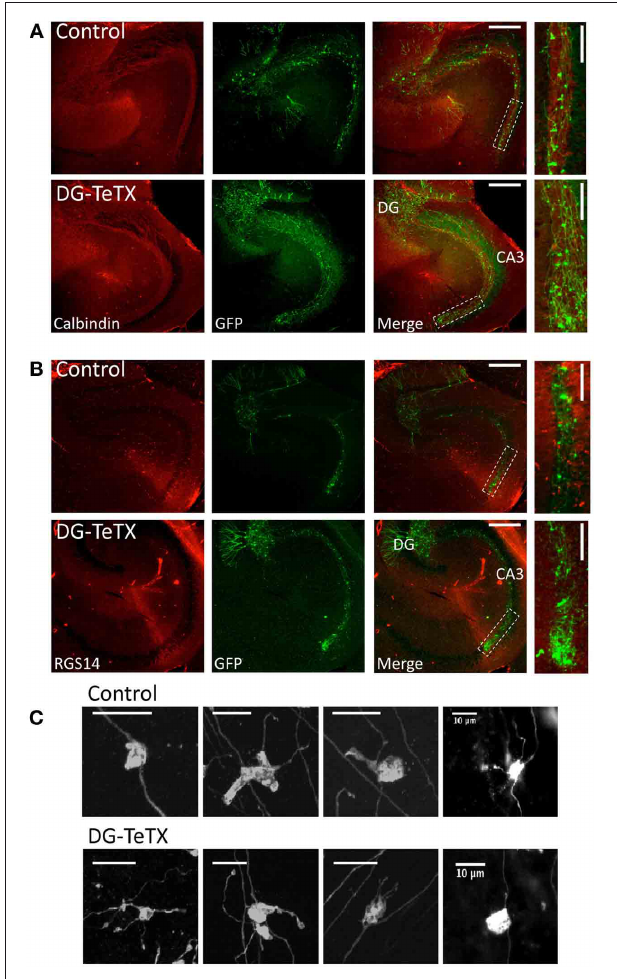
FIGURE 2 | Normal MF projection throughoutCA3 stratum lucidum in activated DG-TeTX mice. (A) Representative images of hippocampal sections obtained from control (upper panels) and activated DG-TeTX mice (lower panels) stained for calbindin (red) to label stratum lucidum and GFP (green) to label silenced old GCs (at least 3 months of age) that were infected with GFP encoding Moloney Virus at their time of genesis (scale bars 300 μ m). Boxed region in the merged images indicate regions that were digitally magnified in images at the far right (scale bars 100 μ m). (B) Similar to (A) except that the sections were stained for GFP (green) and RGS14 (red) to label CA2 pyramidal cells demarcating the distal boundary of CA3. (C) Images of representative GFP labeled MFBs from old GCs in sections from control (upper panels) and activated DG-TeTX mice (lower panels). Similar observations were obtained in a total of 5 mutant and 4 control mice examined 3–6 months after viral infection and maintained under Dox free conditions for this entire period (mutant mice were examined at 100, 127, 182, 182, and 178 days postinfection and control mice were examined in parallel at 100, 127, 189, and 162 days